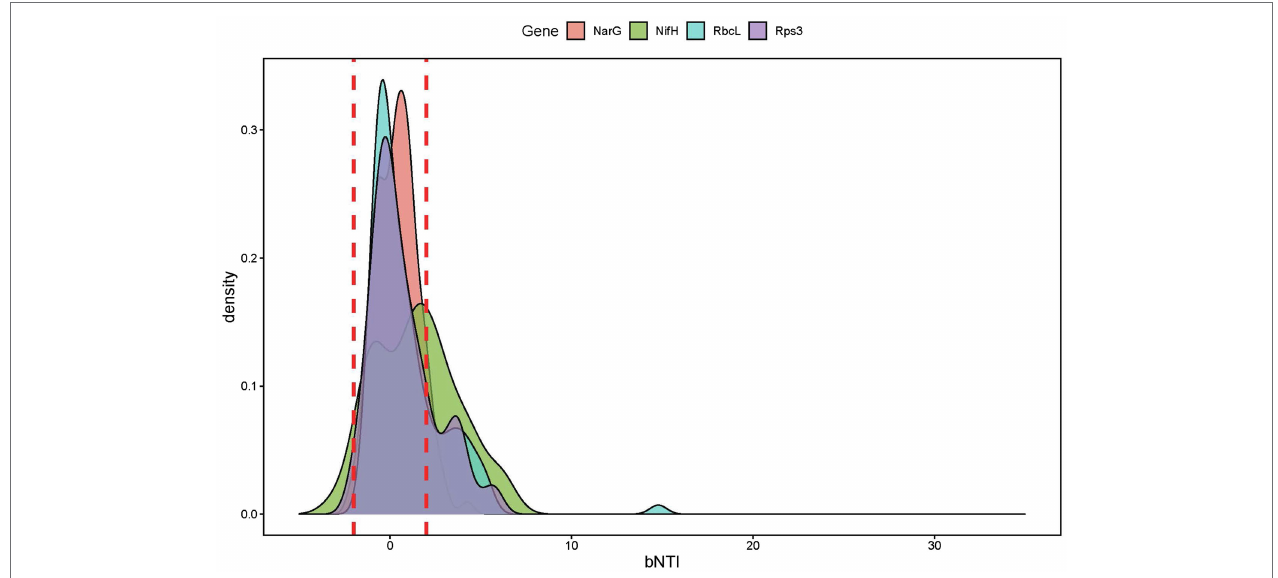
FIGURE 6 | β -nearest taxon index values of the marker genes derived from metagenome sequences show stochastic processes governing the functional community assembly dynamics.